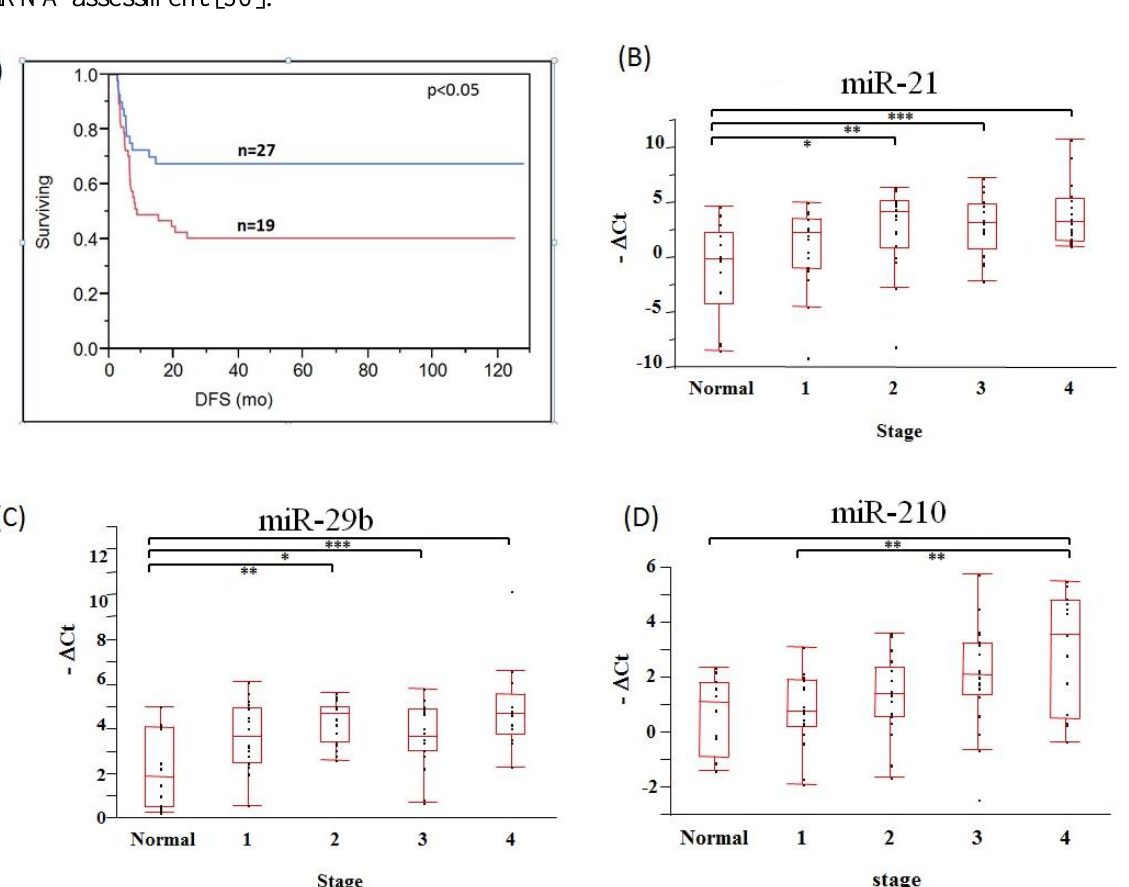
Figure 1. Direct cmiRNA assay of cancer patients ( A ) A level of miR-107 (50th percentile) in bleeds using direct cmRNA assay, taken at Day 0 significantly predict DFS. High levels predict worst prognosis; ( B – D ) Comparison of relative miRNA levels of breast cancer patients and normal samples in serum using a direct cmiRNA assay. The distribution chart shows each cmiRNA levels derived from normal samples vs . each AJCC